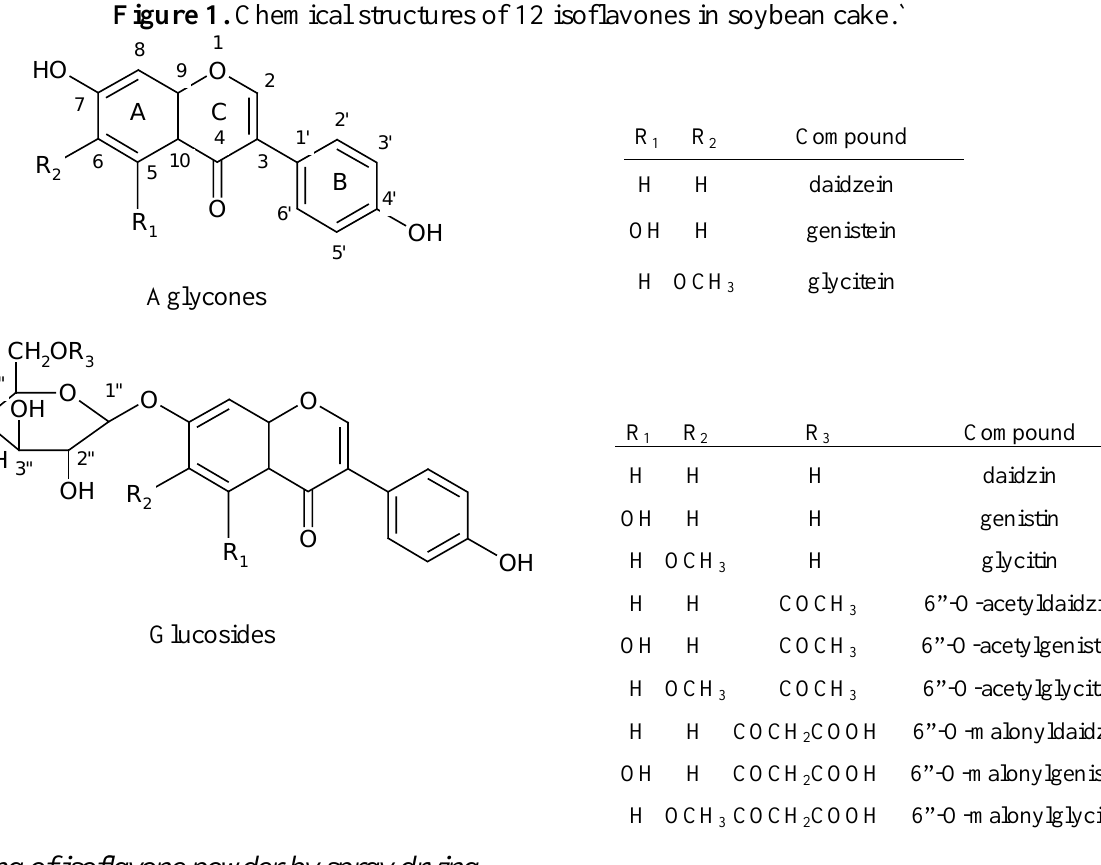
Figure 1. Chemical structures of 12 isoflavones in soybean